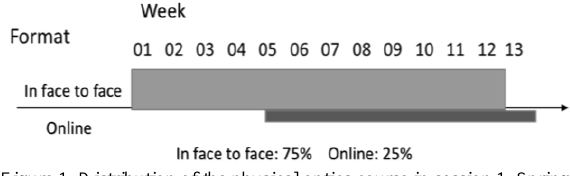
Figure 1: Distribution of the physical optics course in session 1, Spring 2019.